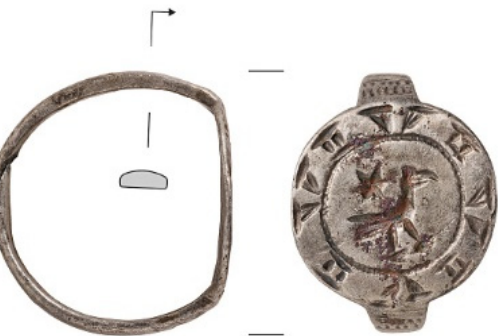
Figure 6. Treasure from Wiener Neustadt. Finger ring with “rising bird” motif, 13th/14th century. Photo: Paul Kolp; editing: Franz Siegmeth.